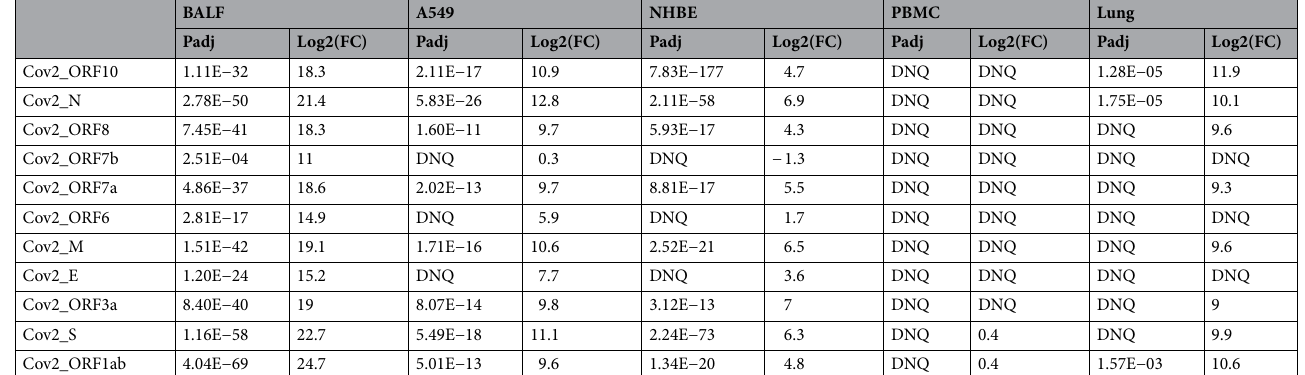
Table 1. SARS-CoV-2 differential gene expression for infected patient tissue and cell line samples compared with non-infected samples. Patient tissue types show dramatically different expression profiles with PBMC and Lung biopsy tissue rarely ever passing detection limits while BALF tissues show robust expression in infected patients. Cell lines also display strong SARS-CoV-2 expression although the magnitude of fold change was far less than that observed in BALF samples. “DNQ” stands for “did not qualify”, which indicates genes that did not pass Cook’s distance filtering in DESeq2 analysis.